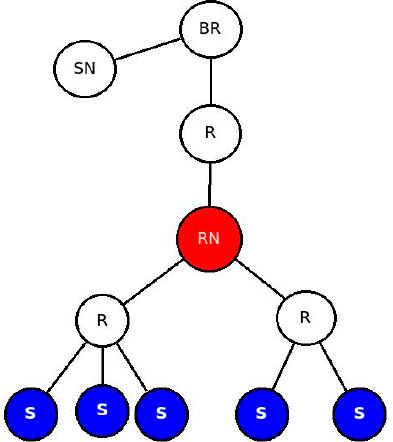
Figure 21. Network Topology including a Node Generating Side Traffic.